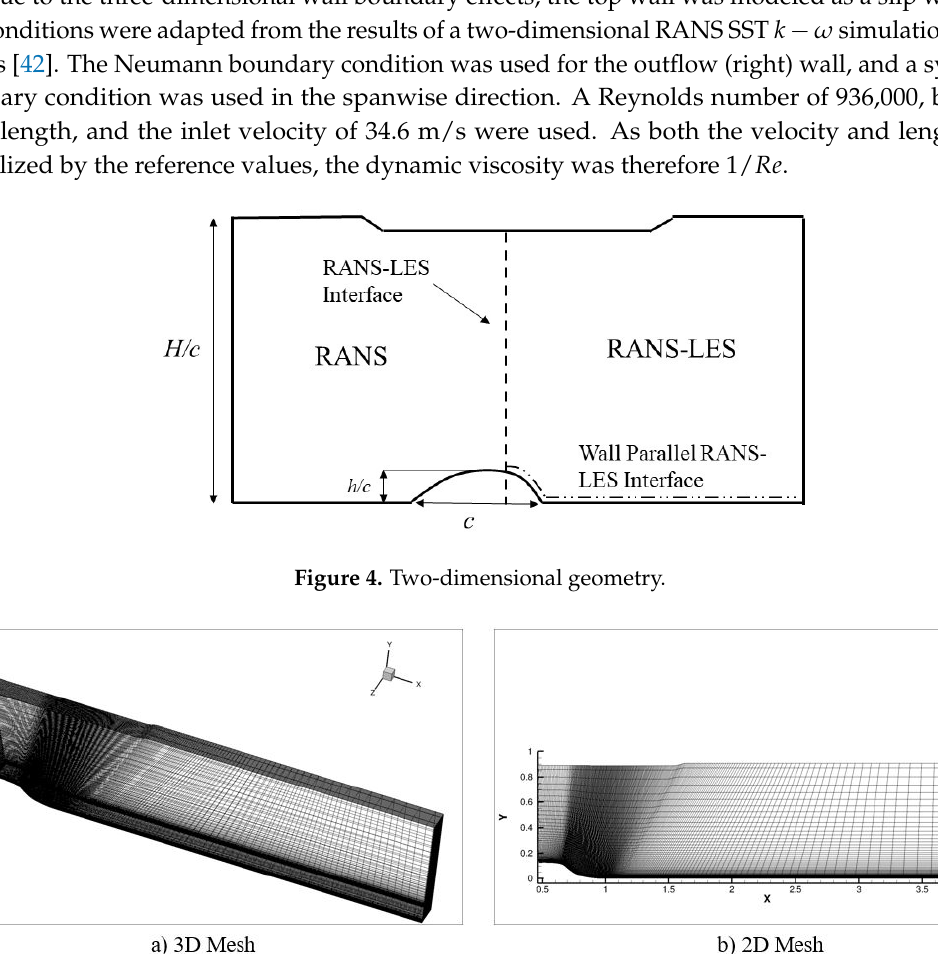
Figure 5. Computational grid.